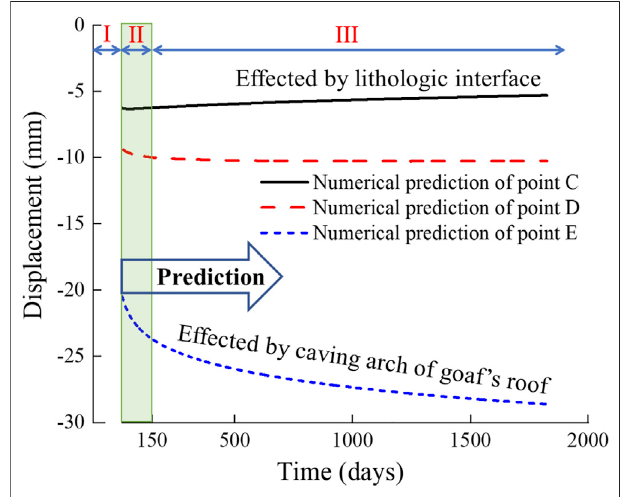
FIGURE 10 | Time-dependent deformation of points C, D, and E obtained by numerical